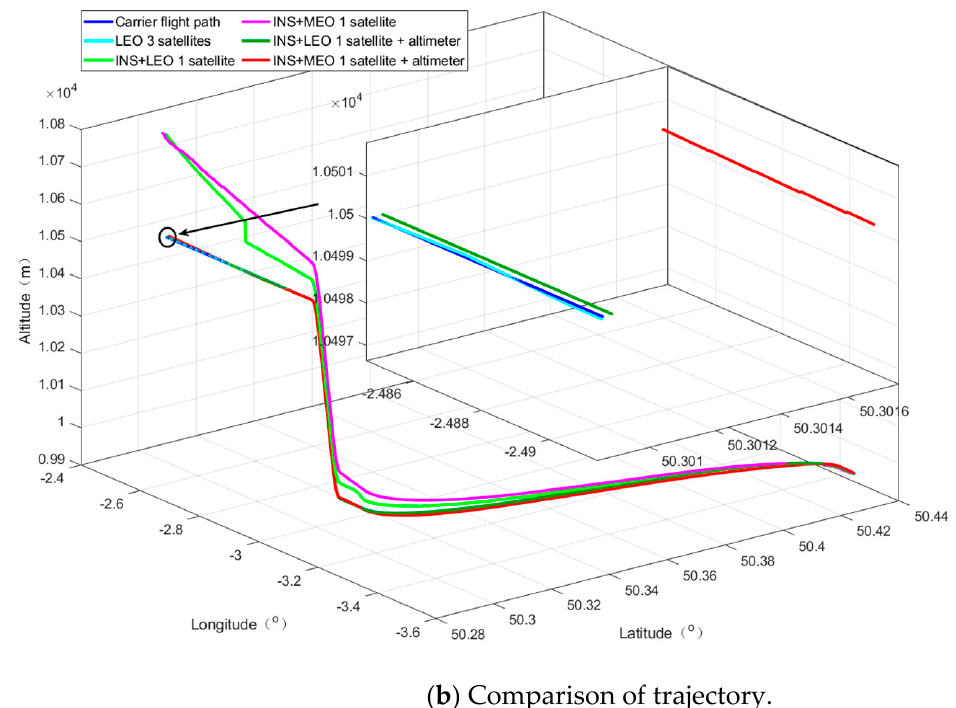
Figure 8. Comparison of LEO and medium earth orbit (MEO) integrated navigation and positioning results.